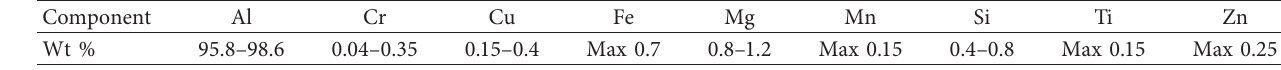
Table 1: Chemical composition of workpiece.